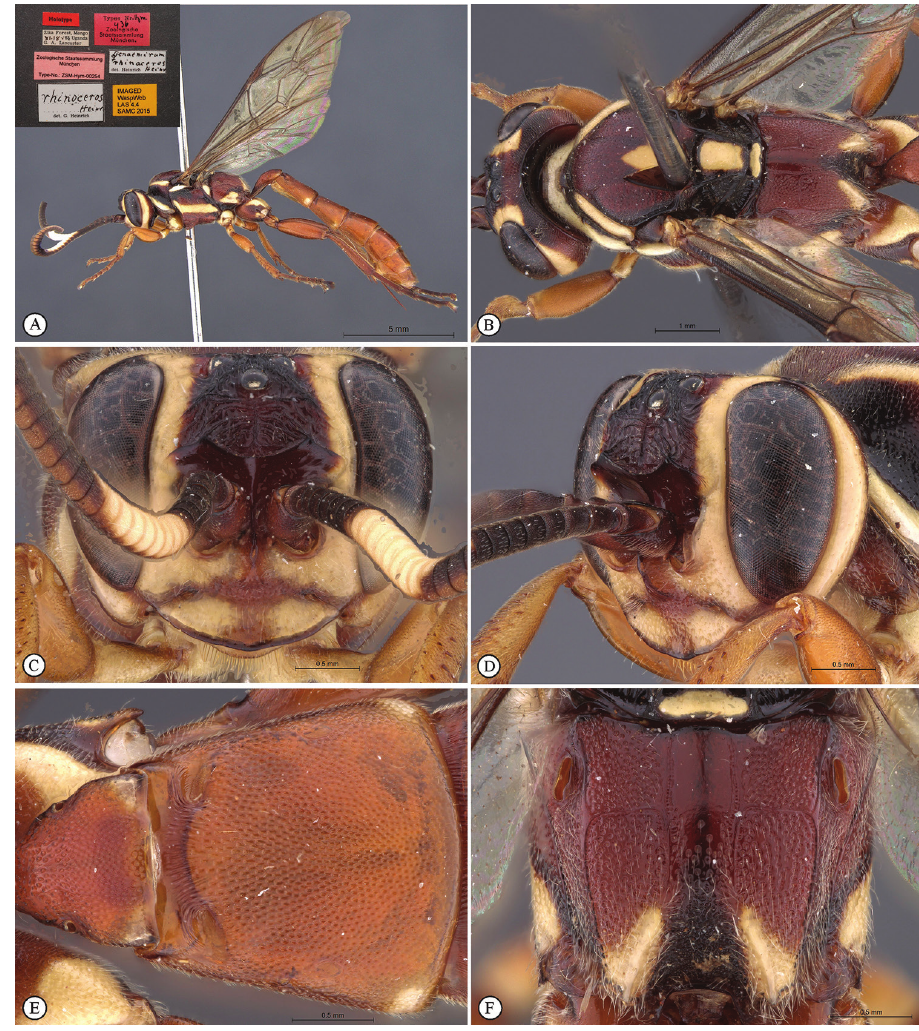
Figure 7. Genaemirum rhinoceros Heinrich. Holotype female. A habitus lateral view (inset: data labels) B head, mesosoma, dorsal view C head anterior view D head, pronotum anterior-lateral view E metasomal tergites 1-2 dorsal view F propodeum, dorsal view.